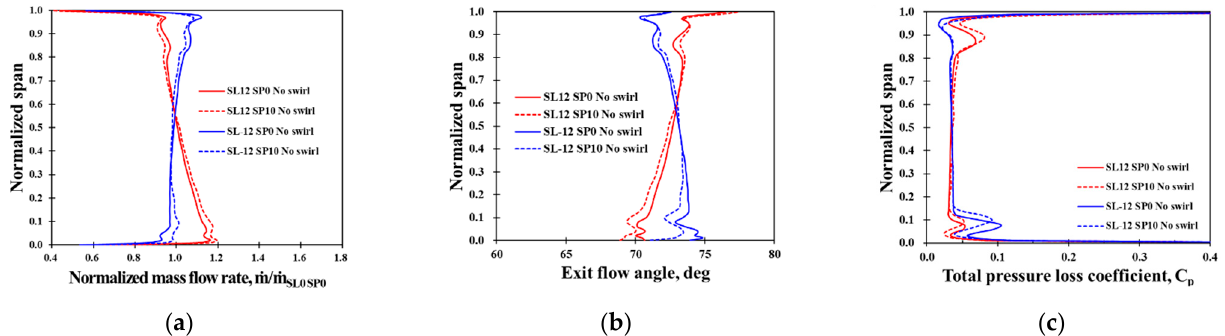
Figure 17. Comparison of circumferentially averaged mass flow rate ( a ), exit flow angle ( b ), and total pressure loss coefficient